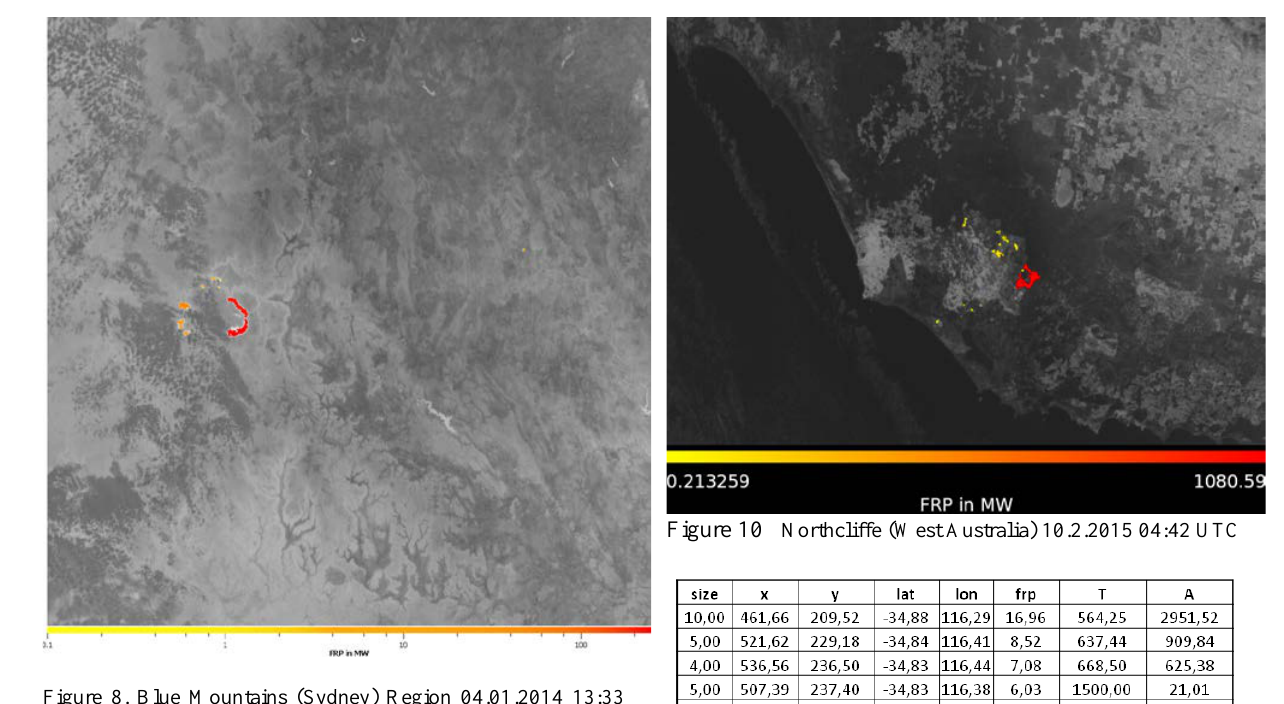
Figure 8. Blue Mountains (Sydney) Region 04.01.2014 13:33 UTC